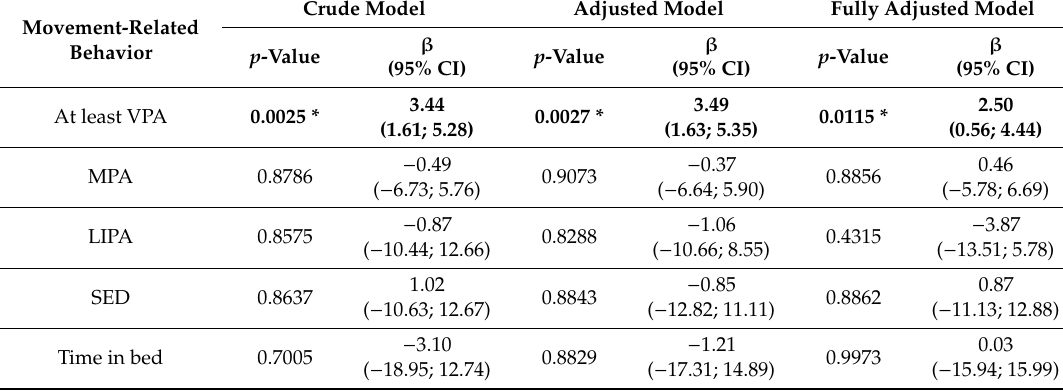
Table A8. p -Values, beta coe ffi cients (95% CI) for the linear regression models assessing the association between relative time spent in each movement related behavior (at least VPA, MPA, LIPA, Sed, time in bed), relative to the remaining ones, and mental wellbeing. Table displays only results for the first ilr coordinate that contains all relative information about the respective behavior, relative to the geometric mean of the remaining